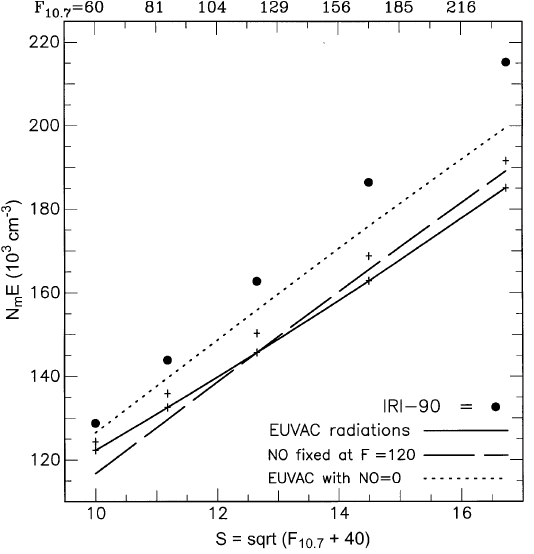
Fig. 7. The electron density at the peak of the E-layer ( N (cid:109) E ) plotted as a function of ( F (cid:49)(cid:48)(cid:46)(cid:55) # 40) (cid:48)(cid:46)(cid:53) , where F (cid:49)(cid:48)(cid:46)(cid:55) is the 10.7-cm solar flux (top scale). All results are for summer noon conditions at a latitude of 40 ° N, with (cid:115) " 16.5 ° . Solid dots represent mean observed values for these conditions, from the IRI-90 empirical model. The continu - ous line is from calculations using the EUVAC radiation model. Broken and dotted lines are obtained when the changes of NO density with F (cid:49)(cid:48)(cid:46)(cid:55) are suppressed. Points marked # are with half the normal